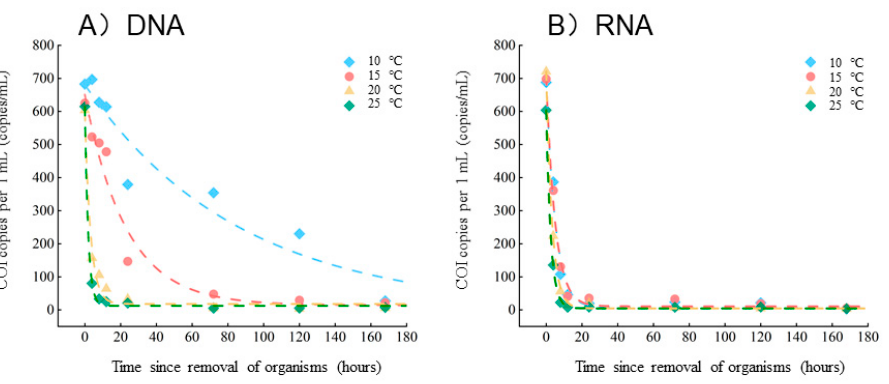
Figure 6. Time-dependent changes at four temperatures (10, 15, 20 and 25 °C) for: ( A ) DNA and ( B ) RNA.